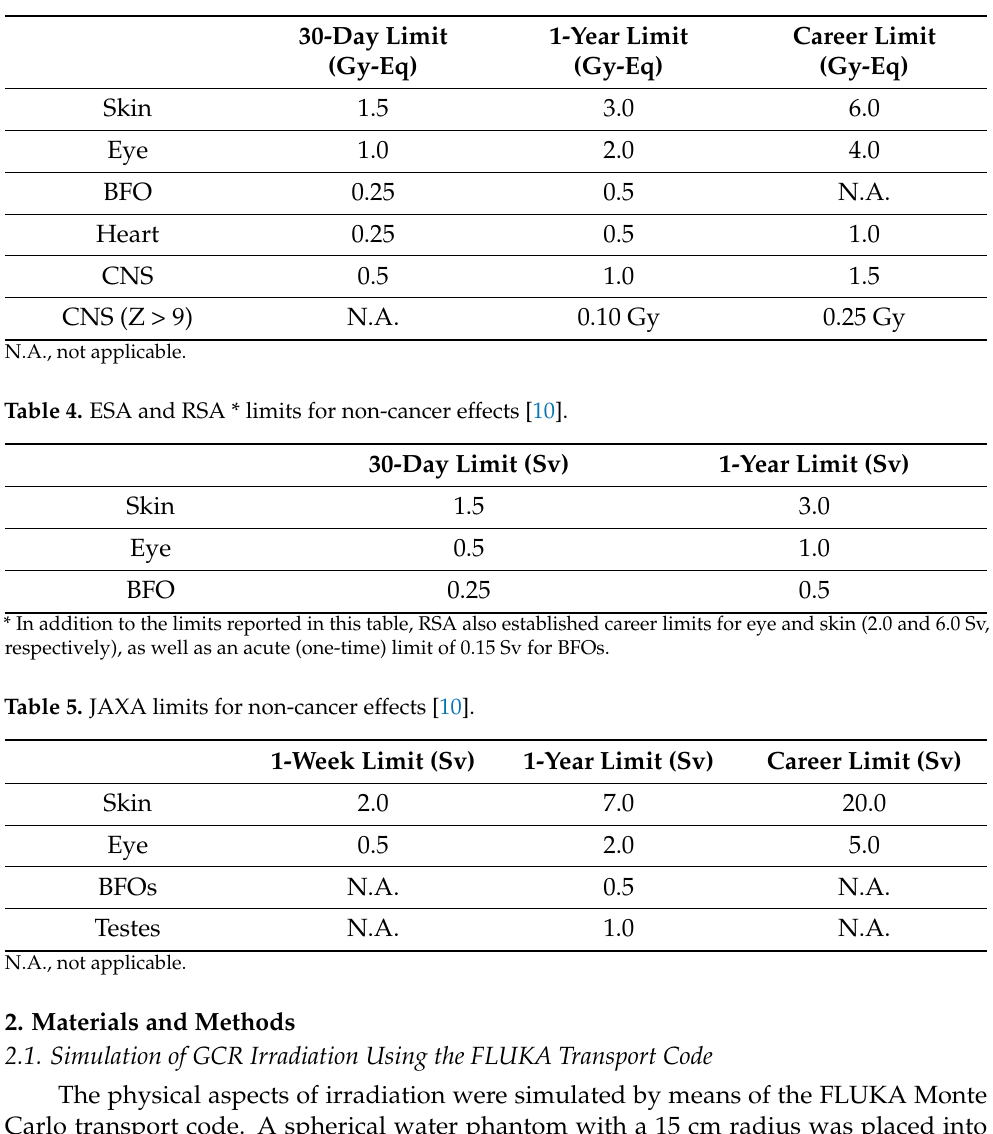
Table 3. NASA limits for non-cancer effects [12].